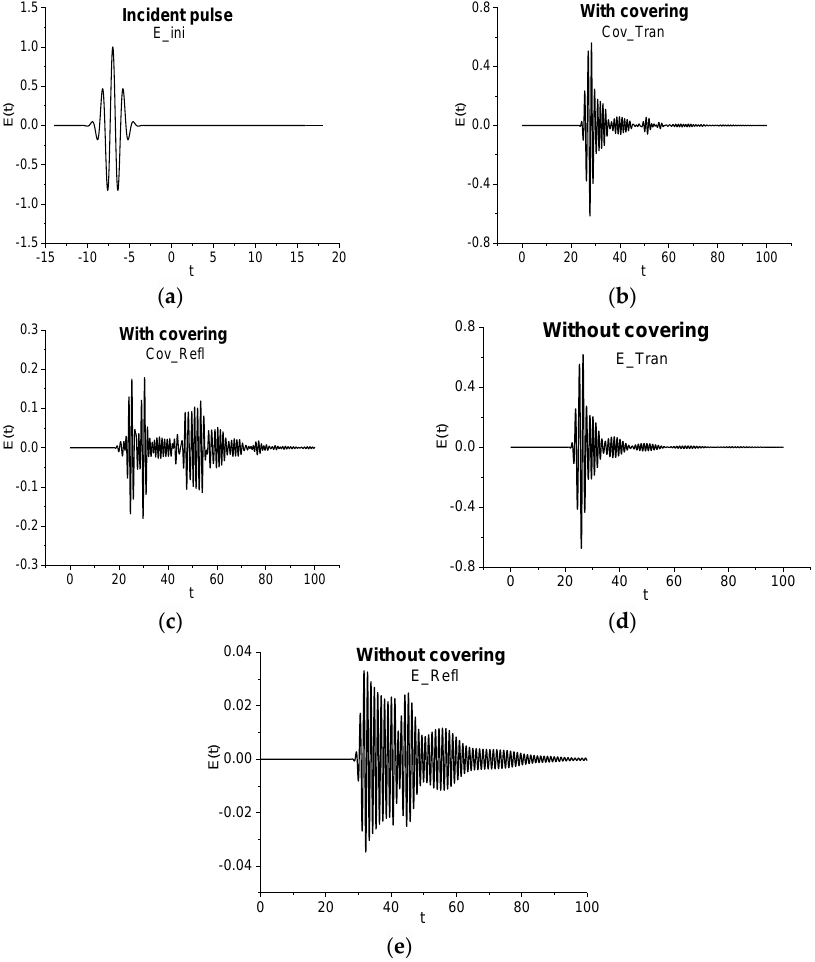
Figure 5. The incident pulse (E_ini) ( a ), pulses (Cov_Tran, E_Tran and Cov_Refl, E_Refl), correspondingly, transmitted through ( b,d ) and reflected from ( c,e ) the medium with ( b,c ) and without ( d,e ) covering.